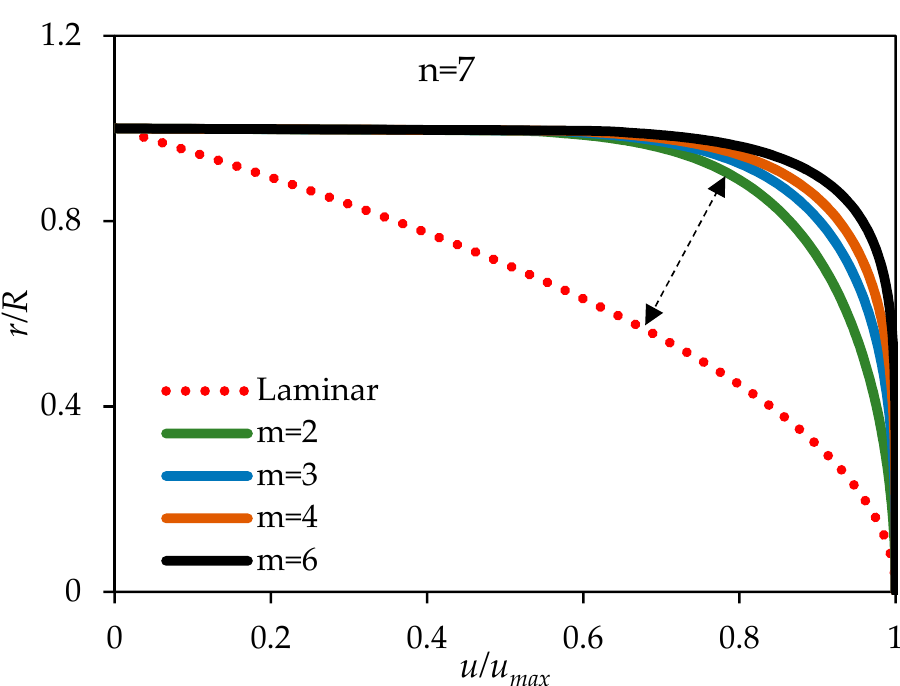
Figure 5. Normalized velocity profiles for different m when n = 7.